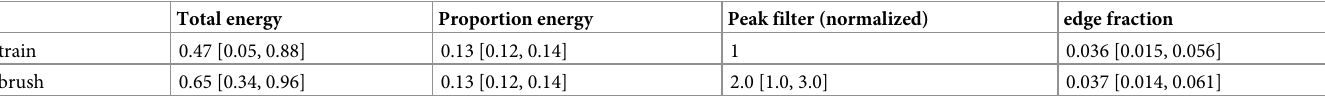
Table 1. Texture analysis results for images from online sources (grand means [95%